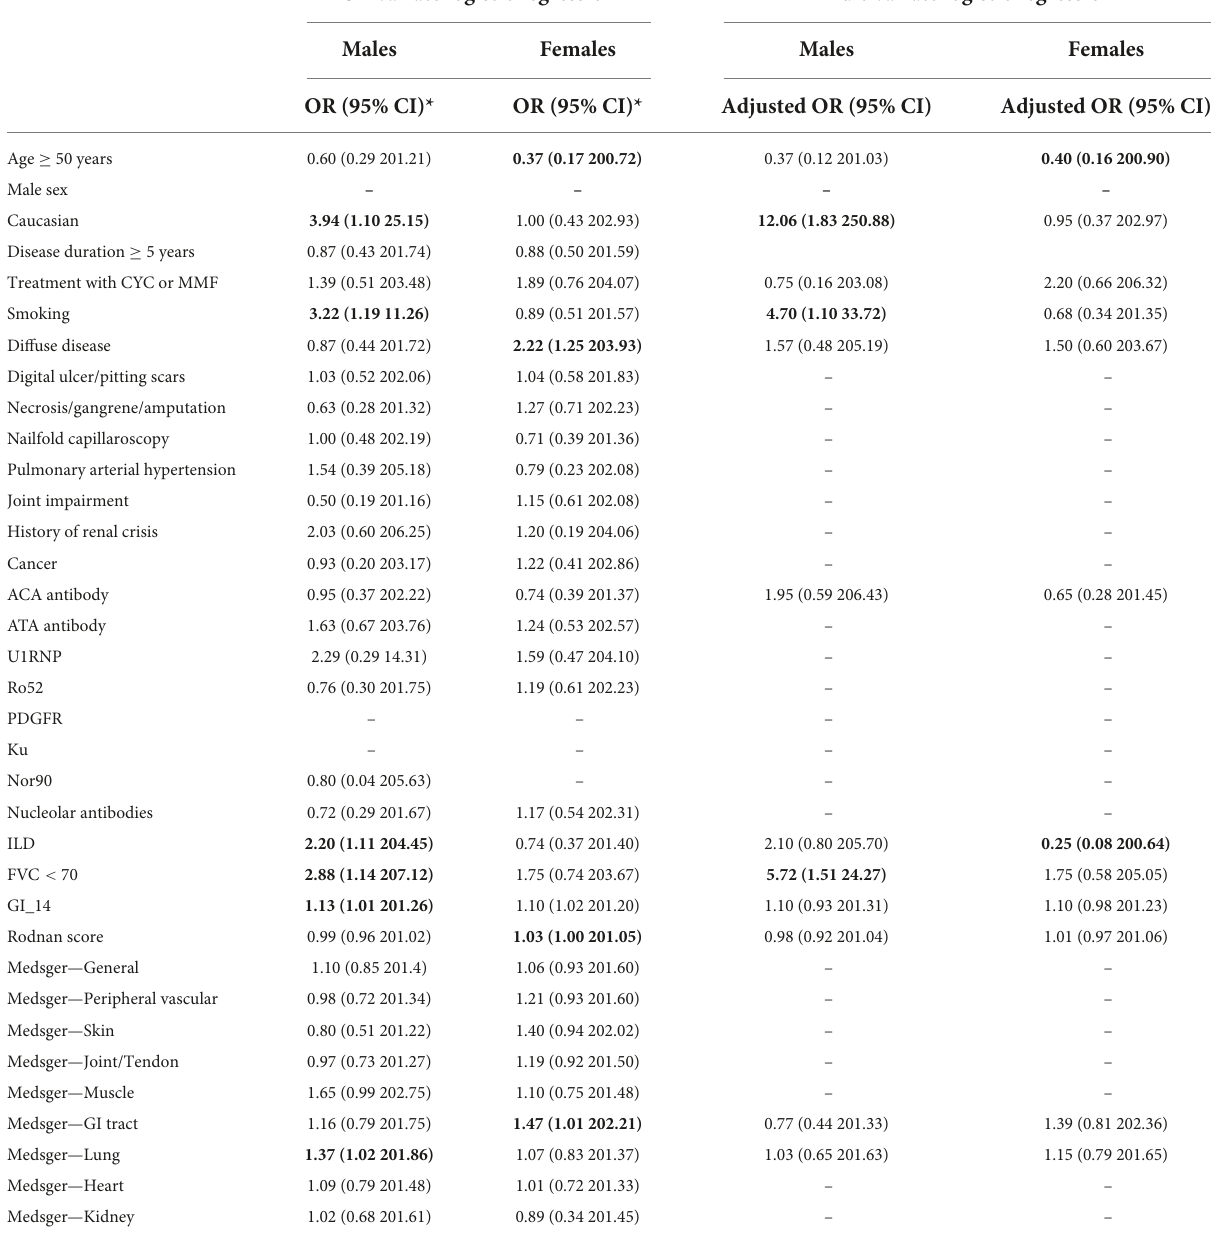
TABLE 3 Univariate and multivariate logistic regression model for factors associated with exposure to silica among male and female patients. Univariate logistic regression